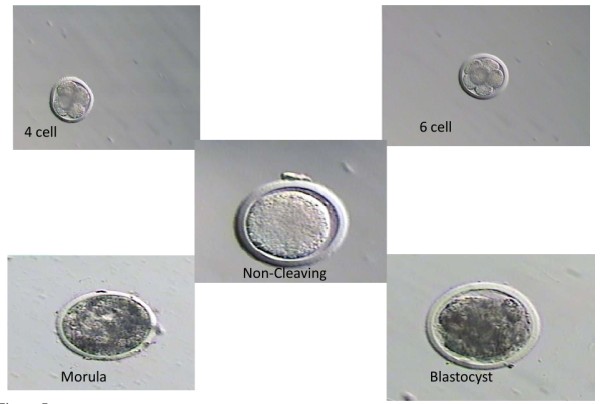
Microphotographs of individually cultured viable and non-viable bovine IVF embryos. It shows a representative group of bovine embryos cultured from the 6-cell to blastocyst stage, which were used to determine PIF levels in their culture medium as well a non- cleaving embryo, control.